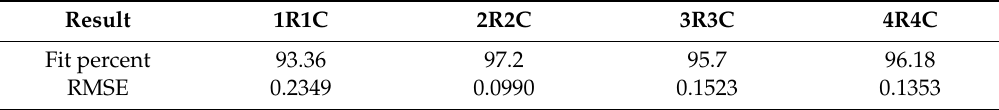
Table 10. Fifteen-minute prediction results for experiment C.